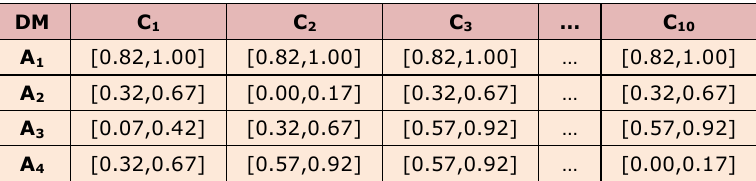
Table 3. Intervaldecision matrix